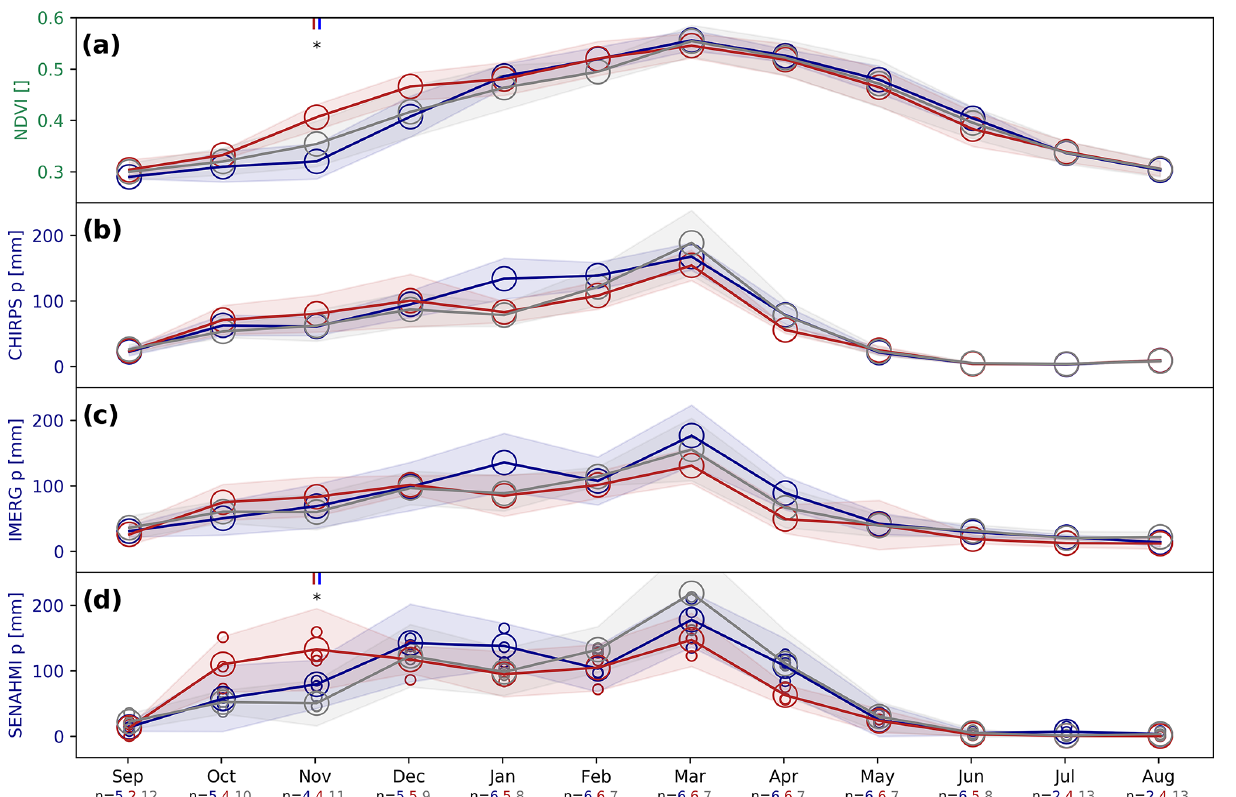
Figure 7. Mean monthly seasonal time series for the 2000–2020 time series of NDVI and three rainfall products. Red (blue, gray) color indicates the month in El Niño (La Niña, neutral) classification after Trenberth (1997) of Niño 3.4. sea surface temperature anomalies (SSTa). We shifted the time series of SSTa by forward by 3 months to account for lagged responses of rainfall in the RSB (Maussion et al., 2015). Below the x axis, the number of months of each phase are displayed. Stars indicate significant results according to a Kruskal–Wallis and post hoc Conover’s test ( P < 0.05, corresponding phase marked by colored bars above the star). For panel (d) , the average time series of three stations in the RSB were used, smaller circles indicating values of the three individual stations. Locations of these stations are shown in the bottom right panel of Fig. 3.